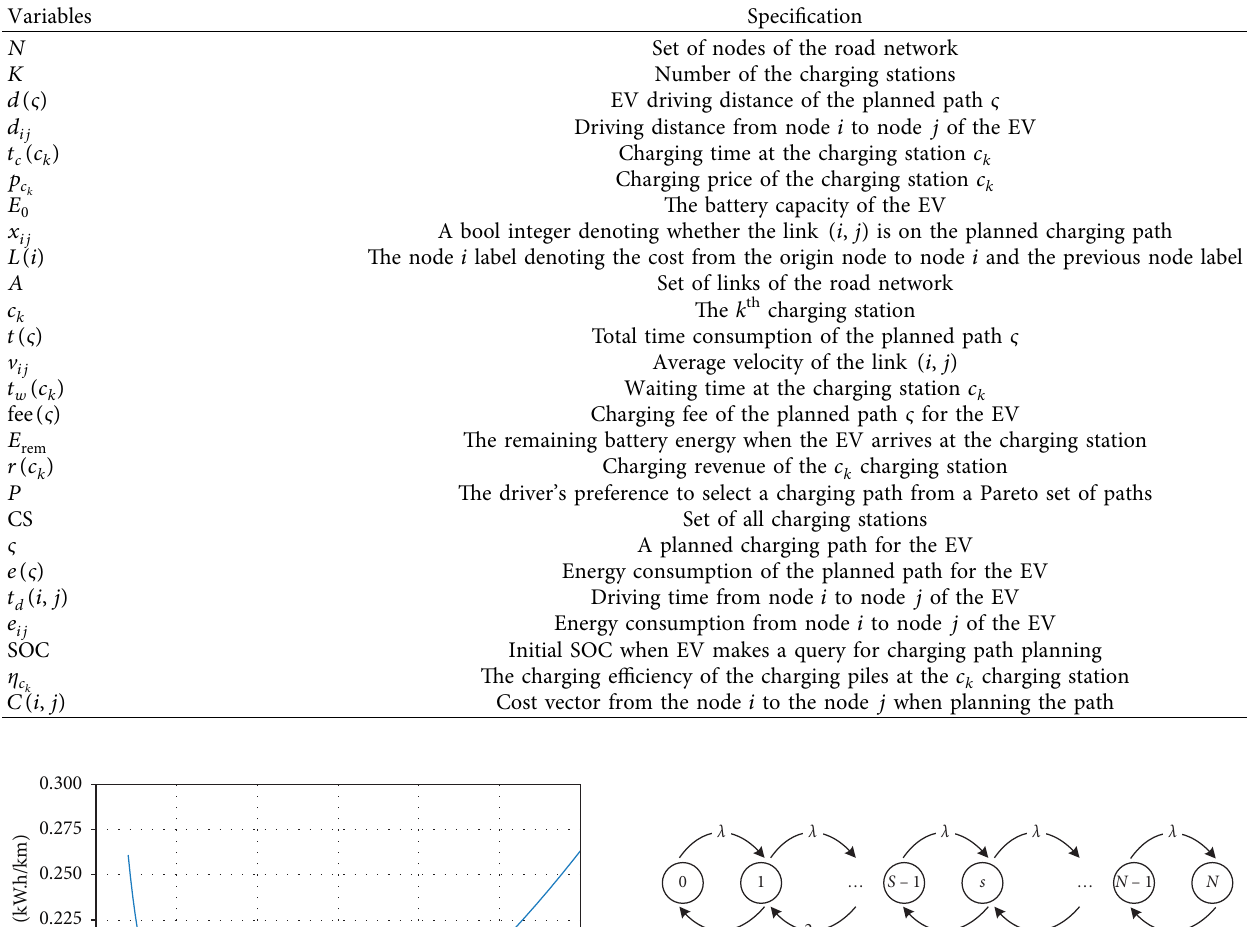
Figure 2: Markov chain of the EV charging